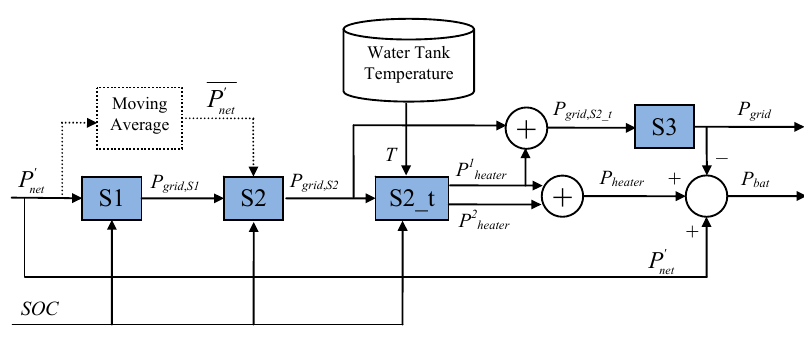
Figure 10. Block diagram of the proposed